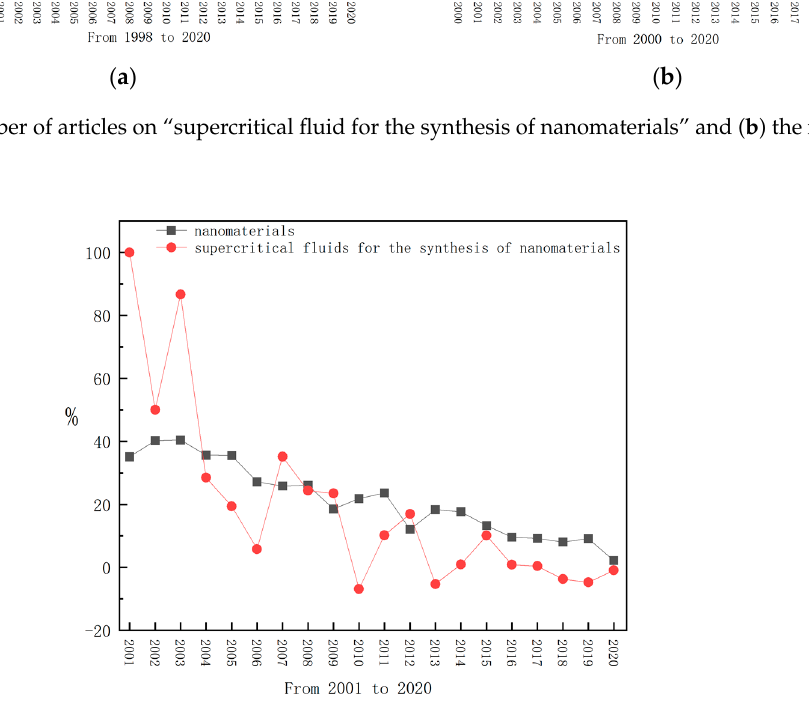
Figure 3. Percentage increase in the number of articles from 2001 to 2020.